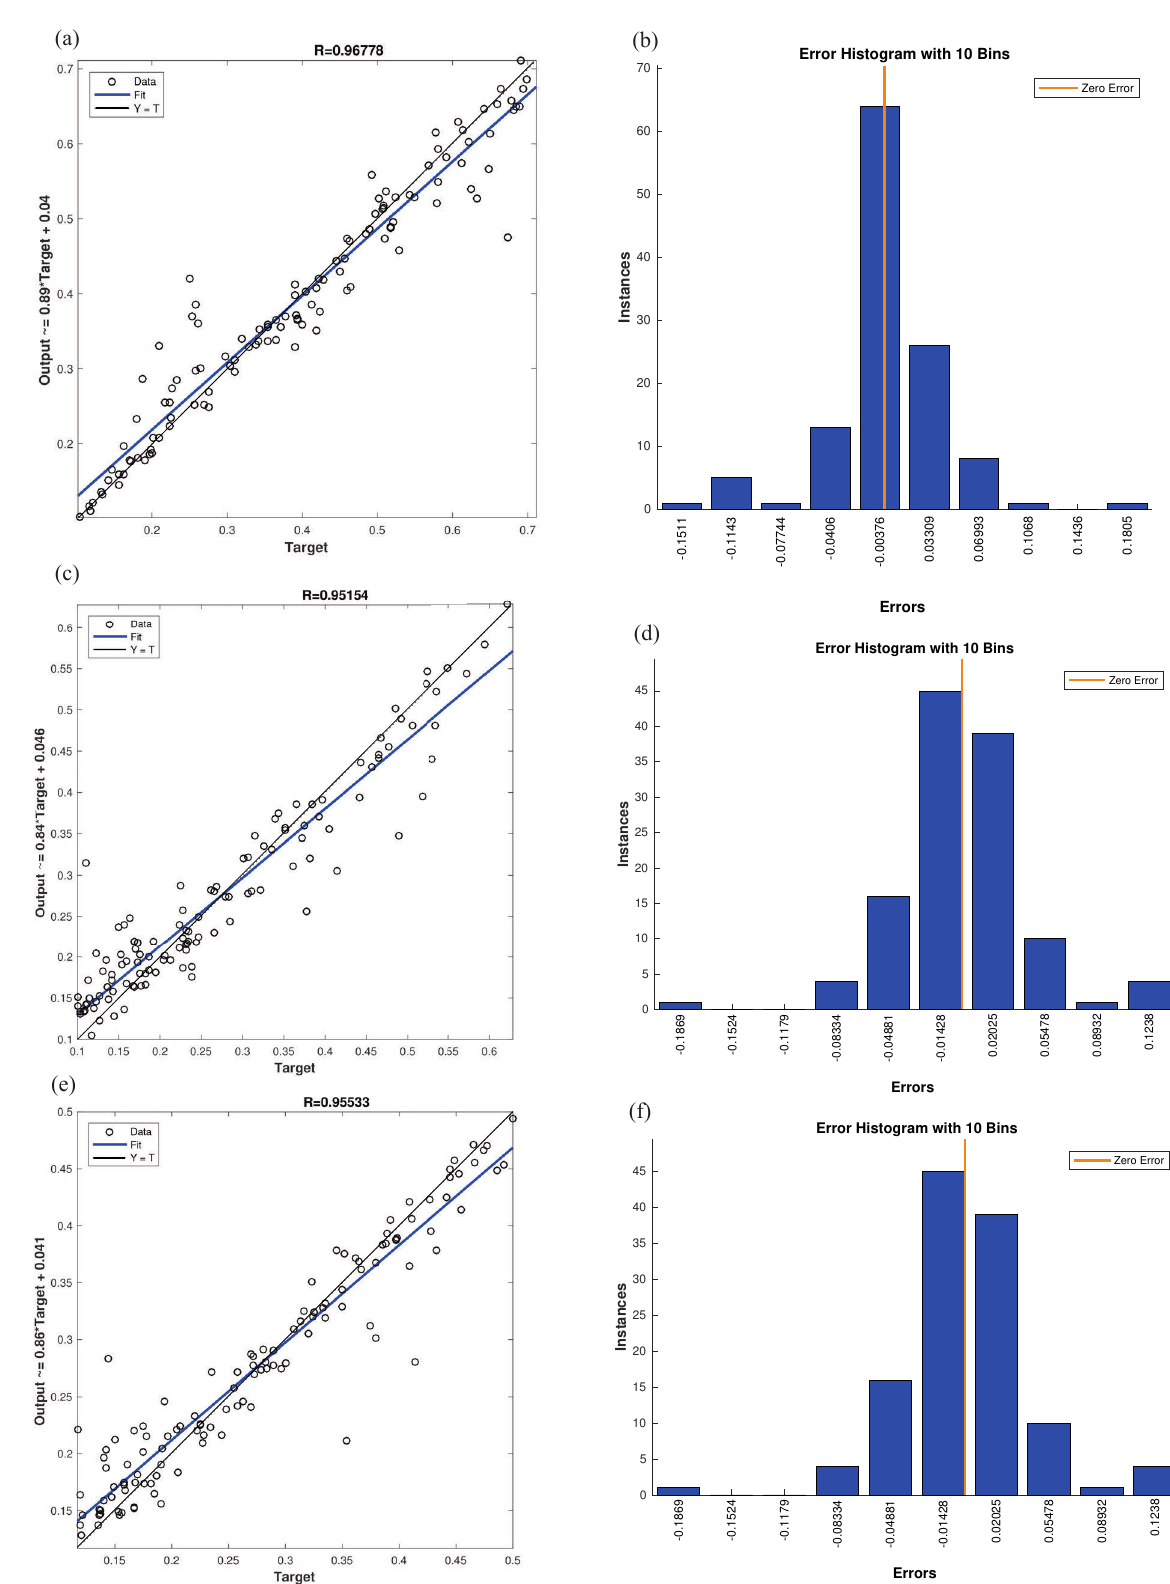
Fig. 3. Correlation and error distribution of the predicted cracks by the ensemble of the ANNs: (a)–(b) location from the left side of the beam; (c)–(d) distance between two cracks; (e)–(f) depth of the first crack; (g)–(h) depth of the second crack. ( Continued on the next page.